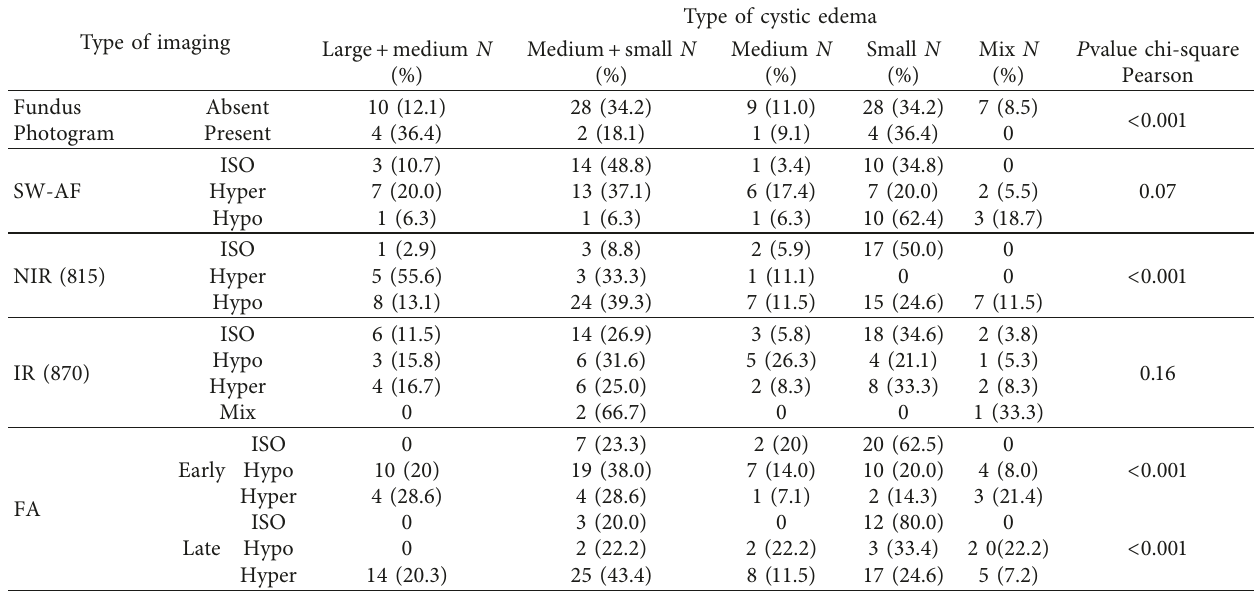
Table 3: Association of the type of cystic changes in SD-OCT with different presentation patterns in common imaging modalities. Type of